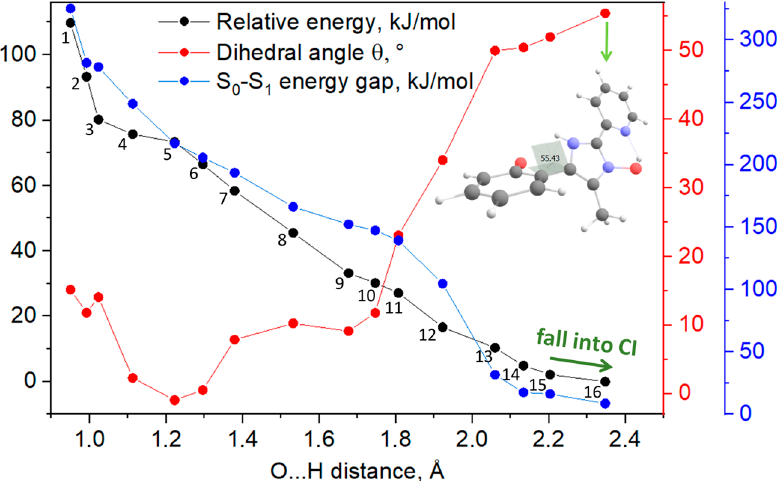
Figure 10. Evolution of energy, dihedral angle θ and the S 0 -S 1 energy gap during the geometry optimization of the S 1 state for L OH,OH . The number of the optimization cycle is shown near the energy curve (black).